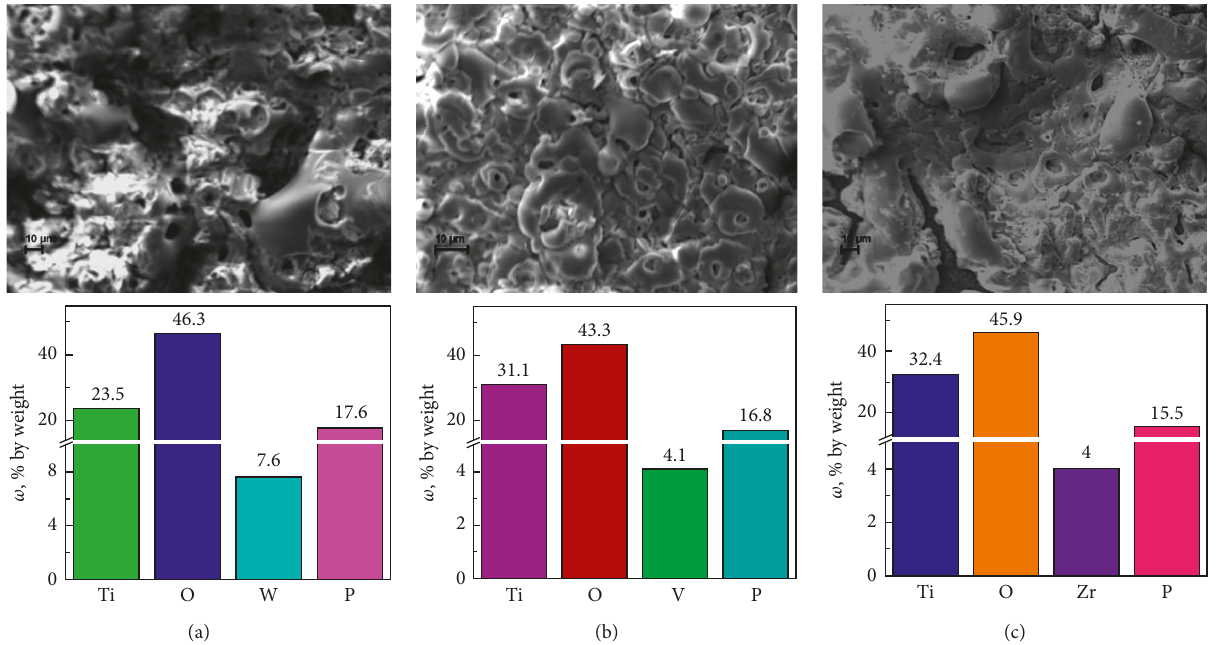
Figure 7: Surface morphology and elemental composition of mixed-oxide coatings TiO VO y ; (c) TiO x ZrO y . Magnification (b) TiO x · ·